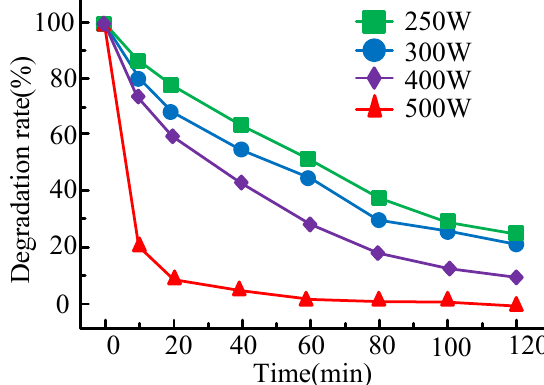
Figure 6. Treatment rate diagram of bisphenol A under different light intensities. It can be seen from Figure 6 that when the light intensity is 250 W, 300 W, 400 W and 500 W, the corresponding bisphenol A treatment rates at 120 min are 76.4%, 77.9%, 88.4% and 100%, respectively, and the corresponding reaction rate constants are 0.012 min − 1 , 0.014 min − 1 , 0.018 min − 1 and 0.051 min − 1 , respectively. It can be obtained that when the